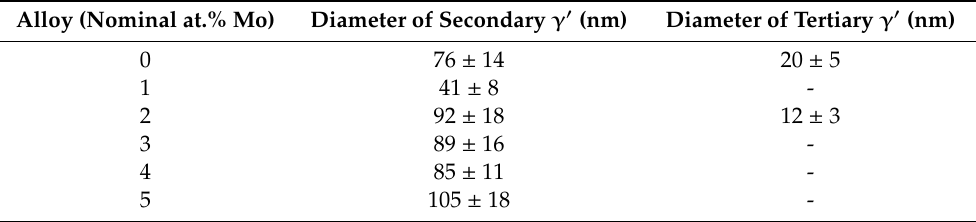
Table 2. Average precipitate diameters of the secondary and tertiary γ′ in each alloy of the series. Alloy (Nominal at.% Mo)